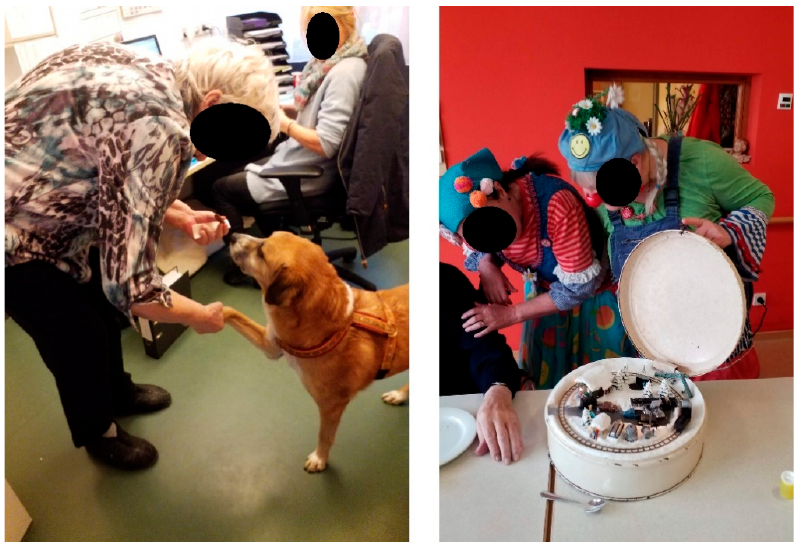
Figure 3. Examples of photographs with social interaction types.